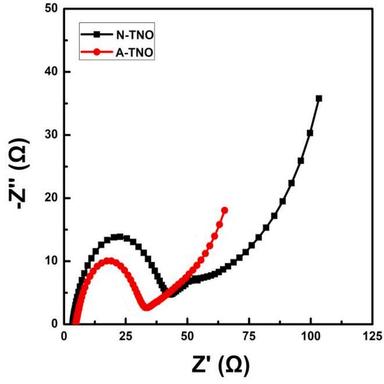
Electrochemical impedance spectra of TiNb2O7 samples synthesized via the solid-state method and the agar-assisted method.